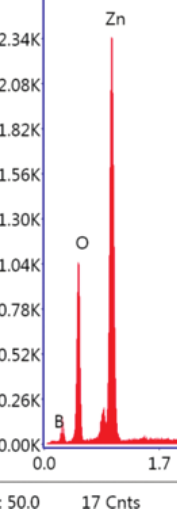
Figure 5: EDS spectrum of solid product obtained at 110°C for 5 h.